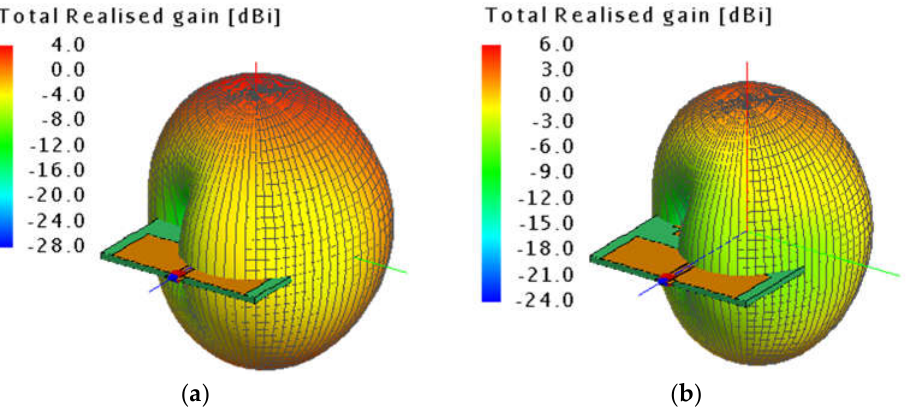
Figure 19. Realized gain at 2.45 GHz for ( a ) step 3 ( b ) step 4.